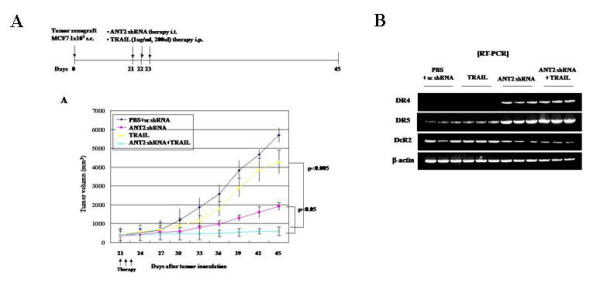
Anti-tumor effects of ANT2 shRNA and TRAIL in a breast cancer xenograft model in vivo. (A) Experimental protocol for tumor challenge and shRNA and TRAIL treatment. BALB/c nude mice were challenged with 5 × 106 MCF7 cells by subcutaneous injection into the right flanks. After 21 days, they began 3 days of treatment with thrice daily intraperitoneal injections of PBS or human recombinant TRAIL with or without thrice daily intratumoral injections of Lipofectamine 2000-supplemented scrambled or ANT2 shRNA vector. Calipers were used to make weekly measurements of tumor dimensions, and tumor volumes were calculated as described in the Methods. Measurements continued until day 45 after tumor challenge. Data were analyzed using the Student t test. Differences are considered statistically significant at P < 0.05. (B) Expression of TRAIL receptors in tumors after shRNA and TRAIL treatment. Tumors were isolated on day 45 after tumor challenge and subjected to RT-PCR using primers specific for human DR4, DR5, DcR2, and GAPDH (internal control).